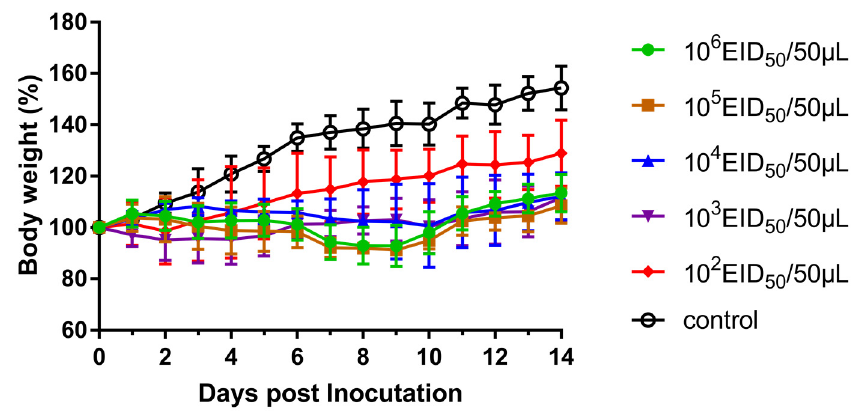
Figure 5. Morbidity rate of the new clade (represented by qk01/2017) CIV in BALB/c mice. Percent- ages of the animal’s weight change on the day of inoculation.